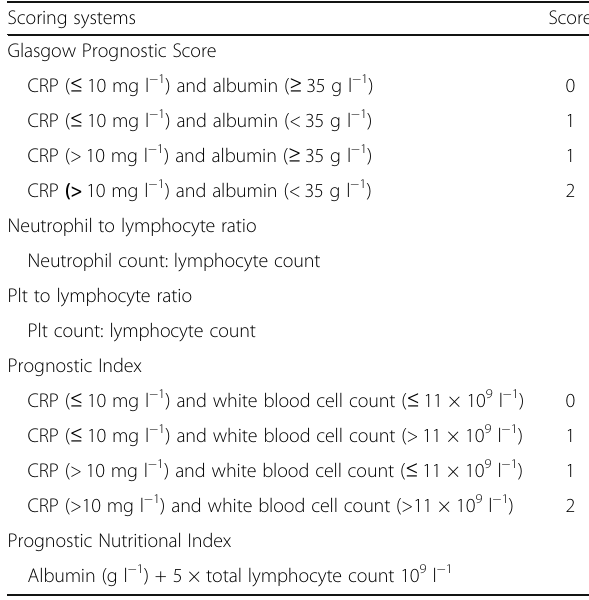
Table 1 Inflammation-based prognostic scores Scoring systems